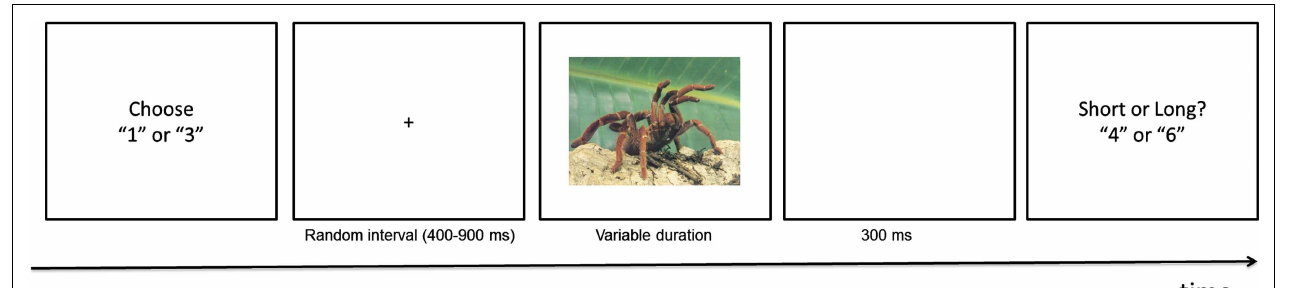
900ms.This variable interval was followed by the presentation of the emotional picture which was presented for one of seven possible durations (400, 600, 800, 1000, 1200, 1400, and 1600ms).The image then was replaced by a blank screen for 300ms.Then participants were prompted to categorize the image duration as short of long on the final